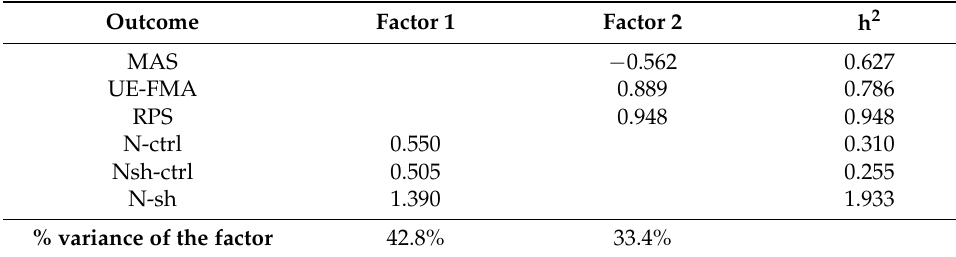
Table 5. EFA1, with promax rotation for variables at